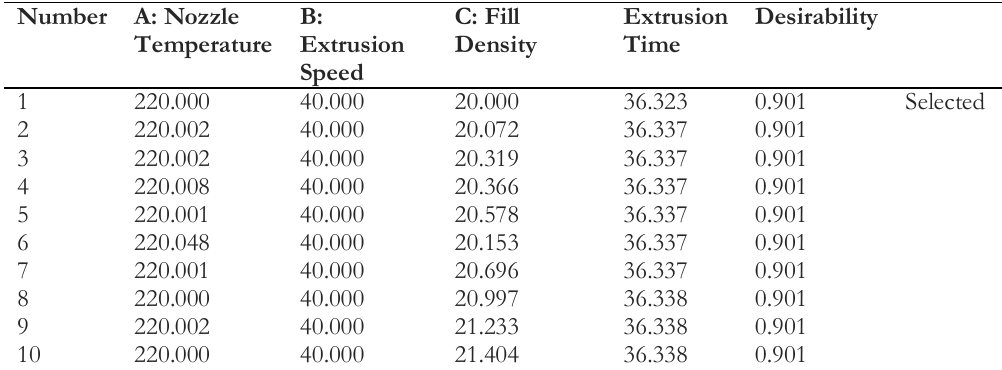
Table 9. Values of process parameters for the optimization of extrusion